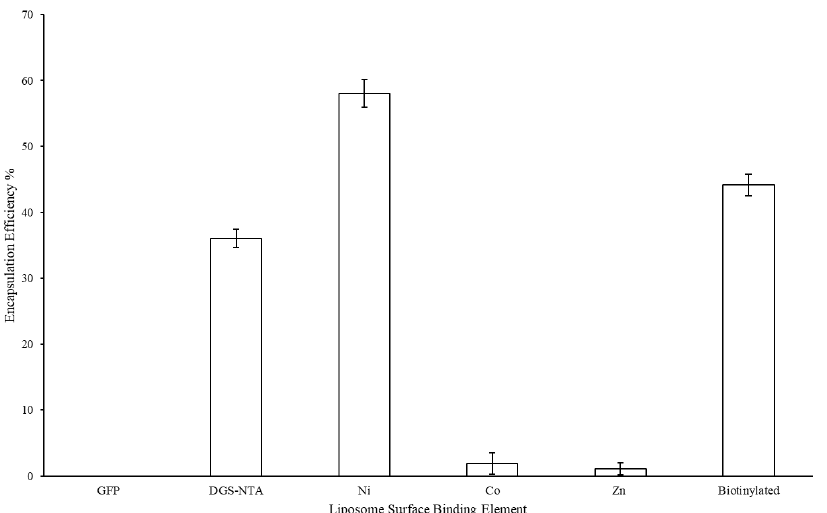
Figure 5. Liposomal encapsulation efficiency of polysaccharide 19F across variants with different protein surface binding elements after protein incubation.